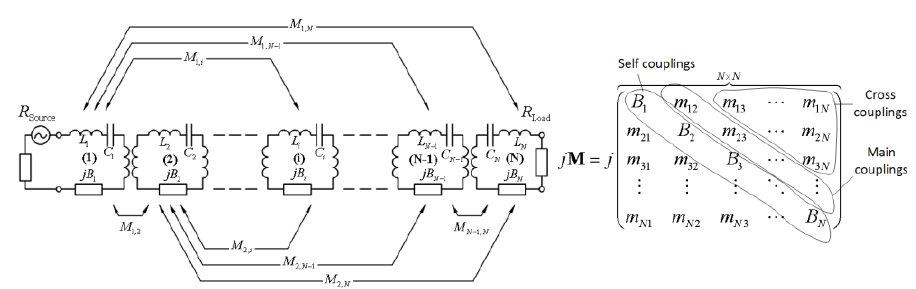
Fig. 3. A QEF bandpass filter prototype circuit that implements an asymmetric frequency response with an arbitrary position of the attenuation poles (left), a general view of the coupling matrix (right).